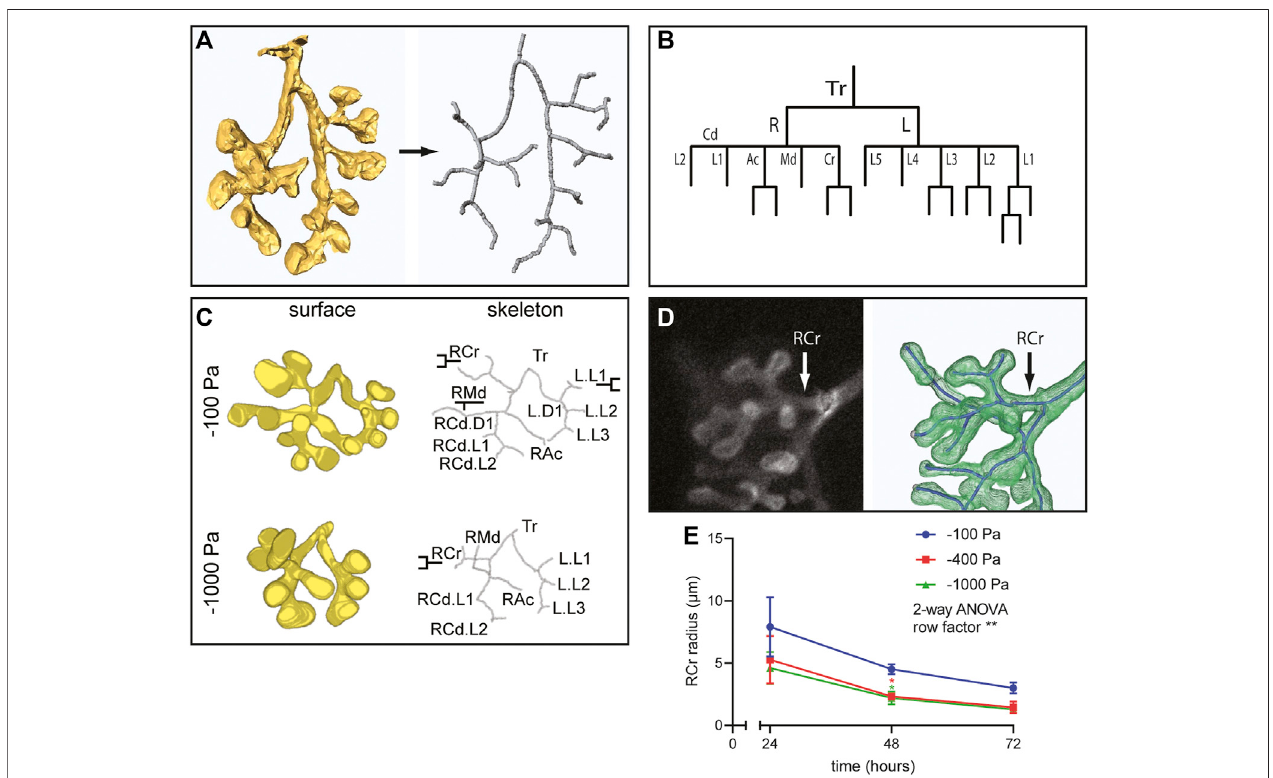
FIGURE 5 | Airway lineage analysis and quantitative morphometric analysis reveal that negative transpulmonary pressure decreases branching without affecting basal epithelial surface area. (A) Schematic of skeletonization routine to identify branching architecture in an unbiased fashion from 3D solid models of the airways. (B) Airway lineage diagram of skeletonized epithelial tree depicted in (A) . The trachea (Tr) bifurcates into the right (R) and left (L) primary bronchi. The right primary bronchus forms the caudal (Cd), accessory (Ac), medial (Md), and cranial (Cr) branches, which generate each of the corresponding lobes of the right lung. The left primary bronchus forms fi ve secondary bronchi (L1-L5). (C) 3D solid models, skeletonizations, and annotated lineages (branch names) for lungs cultured under different pressures. (D) Immuno fl uorescenceanalysisforE-cadherinandschematicofskeletonizedRCrbranch. (E) MeanradiusofRCrasafunctionoftimeforlungexplantsheld at different transpulmonary pressures (N (cid:1) 3 experimental replicates; 3 lung explants/group). Two-way ANOVA was used to test signi fi cant variation of radius with time (row factor p -value (cid:1) 0.0083, denoted as **). One-way ANOVA was used to compare lungs within time points ( p -value (cid:1) 0.0409 and 0.034 for − 100 Pa vs. − 400 and − 1,000 Pa, respectively, at 48 h, denoted as